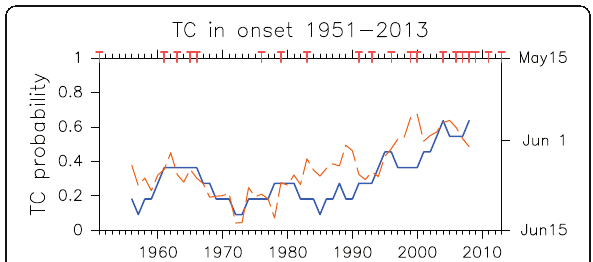
Fig. 12 The probability of TC existence during summer monsoon onset. Existence of TC at monsoon onset (red “ T ” ), 11-year running average of the PTCe (blue line), and Philippine summer monsoon onset date (orange dashed line; same as Fig. 5a) are superimposed